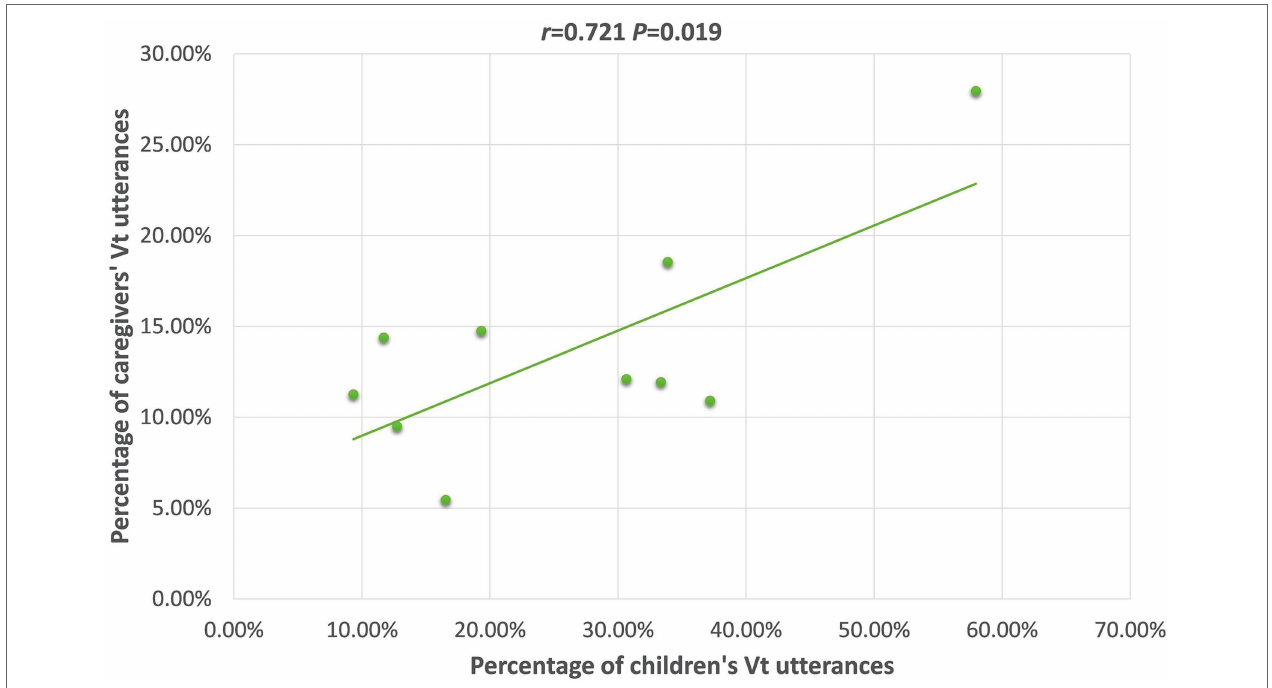
FIGURE 1 | Scatterplot of 26 m TD children’s and caregivers’ Vt